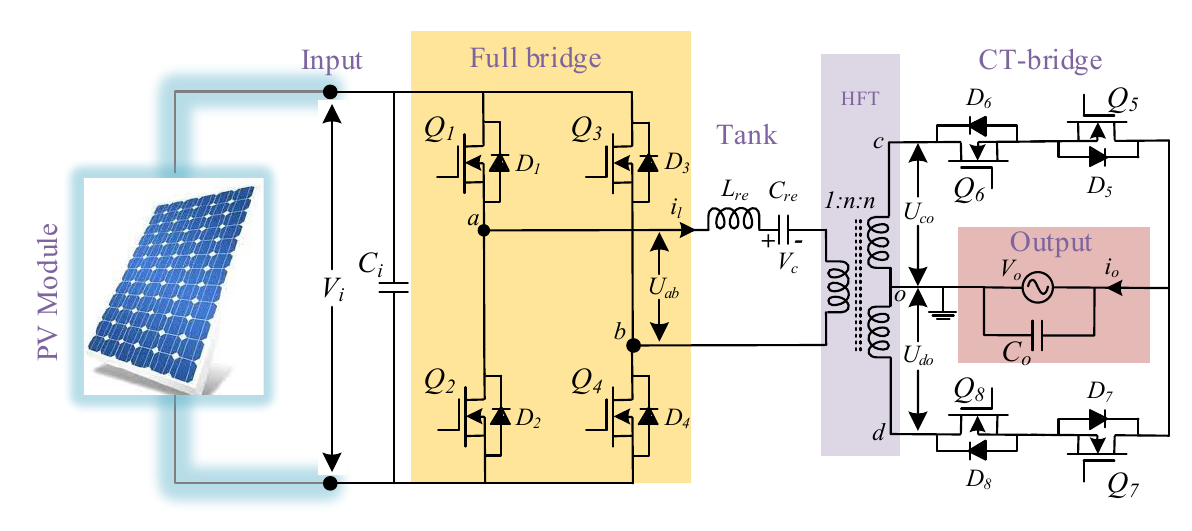
Figure 1. Schematic illustration of the suggested converter topology.